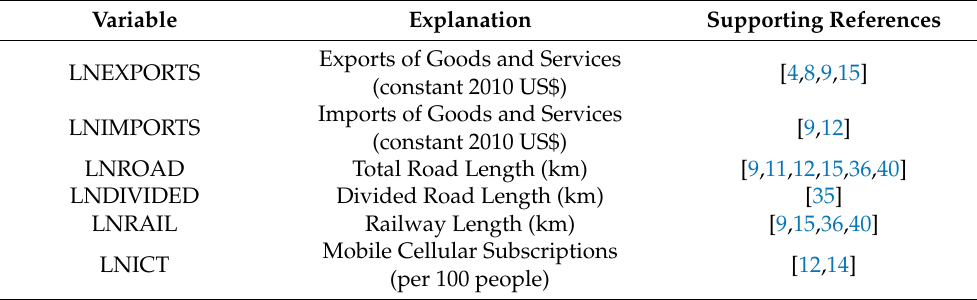
Table 2. Transport-trade factors.